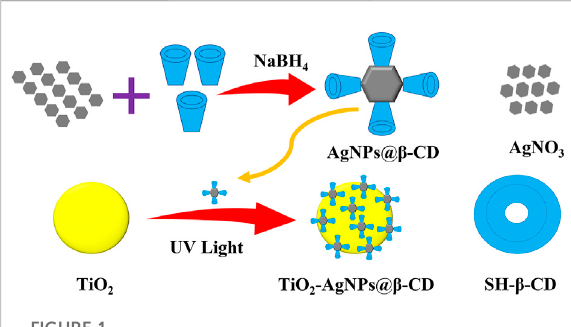
Schematic of the synthesis process of TiO 2 – Ag